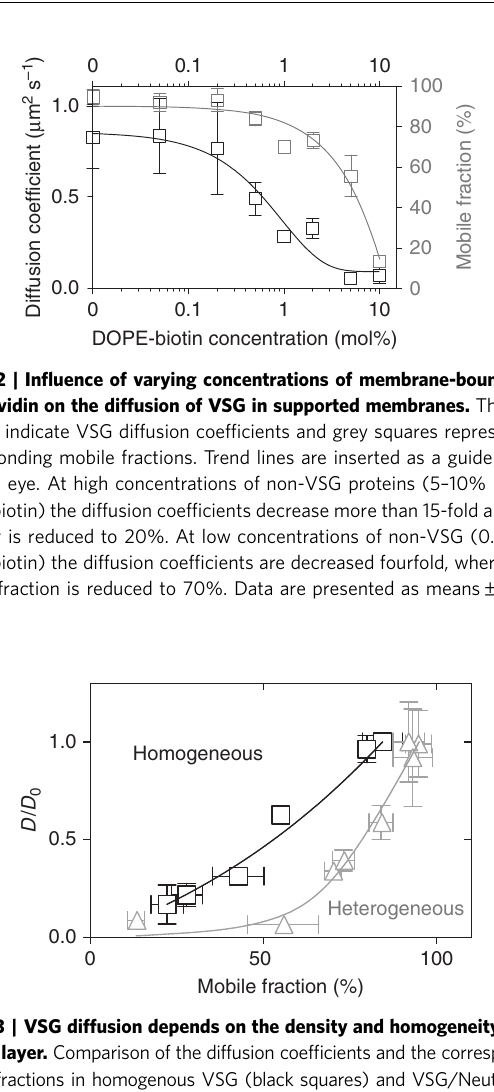
Table 2 | Effect of VSG overexpression on the diffusion of VSG on live cells.